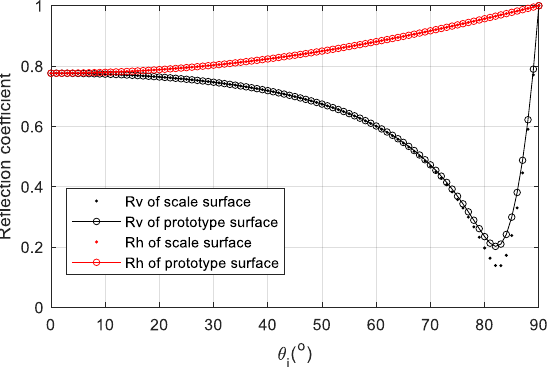
Figure 11. Reflection coefficient of the prototype surface and the scaled surface. The dot represents the reflection coefficient of the scaled sea surface. The solid line with the hollow circle represents the reflection coefficient of the prototype sea surface. The black represents vertical polarization. The red represents horizontal polarization ( T = 9.6 ◦ C, S = 4 psu, f = 7.8 GHz).